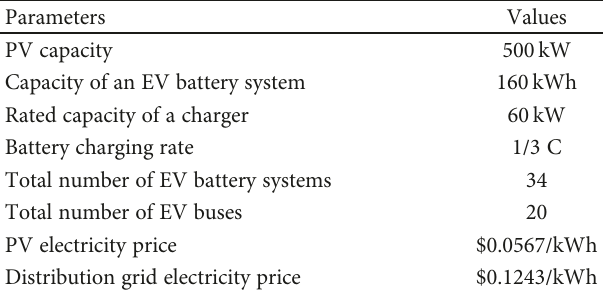
Table 1: BSS case study con fi guration